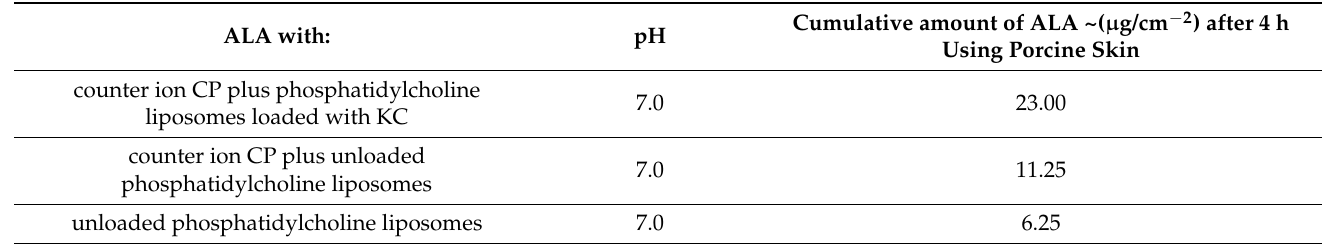
Table 19. Permeation of ALA through porcine skin with unloaded phosphatidylcholine liposomes; with CP counter ion and unloaded phosphatidylcholine liposomes and with CP counter ion and KC loaded phosphatidylcholine liposomes. The concentration of ALA applied in the buffer solutions was 0.4 mg mL ( n ≥ 3 values represent the mean). Adapted from [36], Elsevier, 2003.